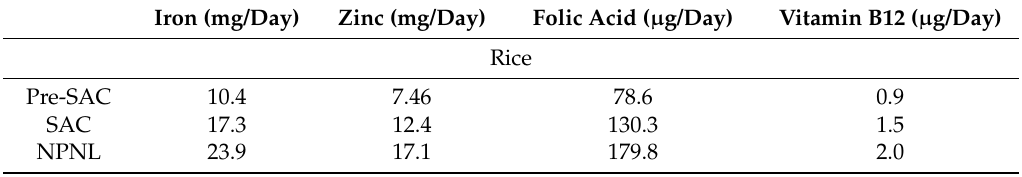
Figure 3. Estimated percentage of upper limit reached from multiple food fortification (based on the upper 95% consumption level and micronutrient intake). Table 5. Estimated daily contribution from fortified rice, bread, and wheat flour (using mean amounts consumed per day by each population group, and proposed fortification levels).